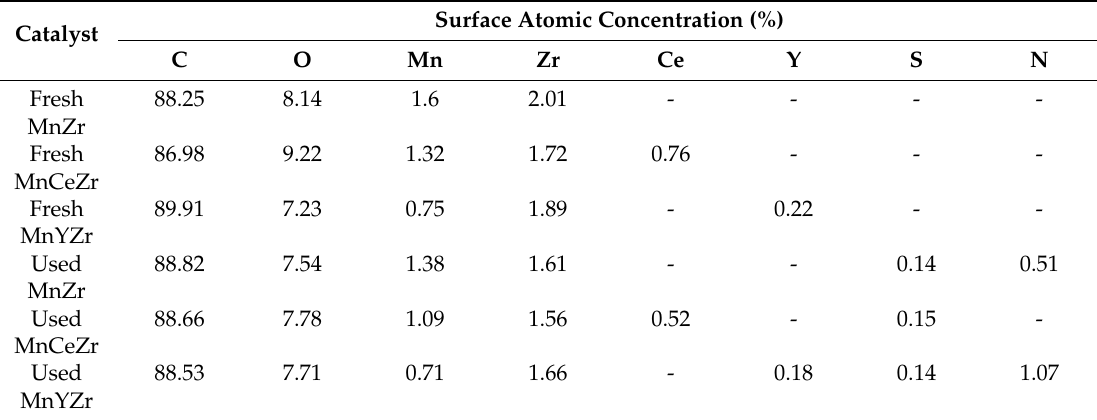
Table 1. Surface atomic concentration of catalysts before and after the reaction in the presence of SO 2 .